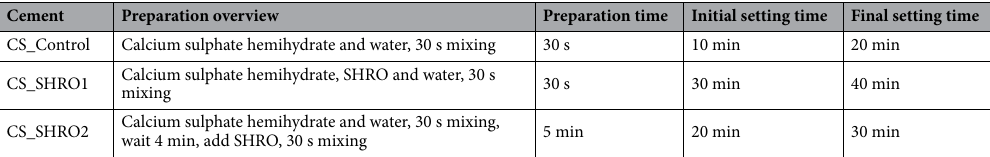
Table 1. Overview of cement preparation and setting parameters. Setting times were acquired from n = 3 pastes and are recorded to the nearest 10 min.